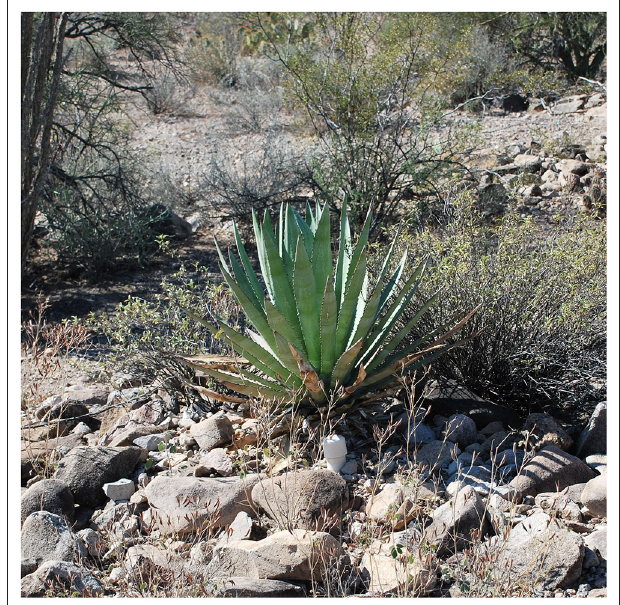
FIGURE 1 | Hohokam rock pile remains at Tumamoc Hill reserve in Tucson,